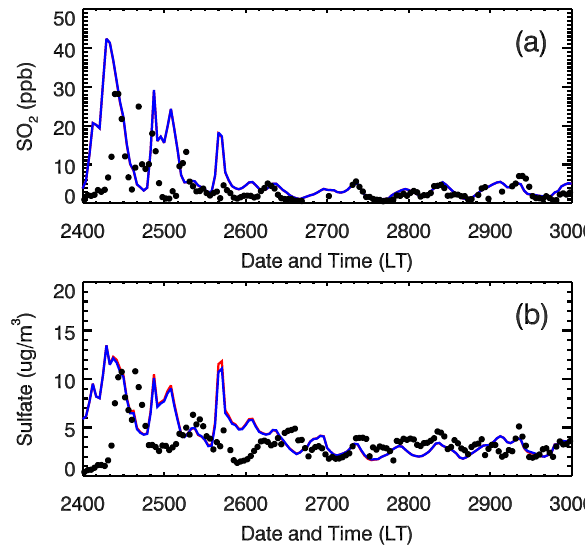
Fig. 13. Same as Fig. 8, except for (a) SO 2 and (b) submicron sulfate